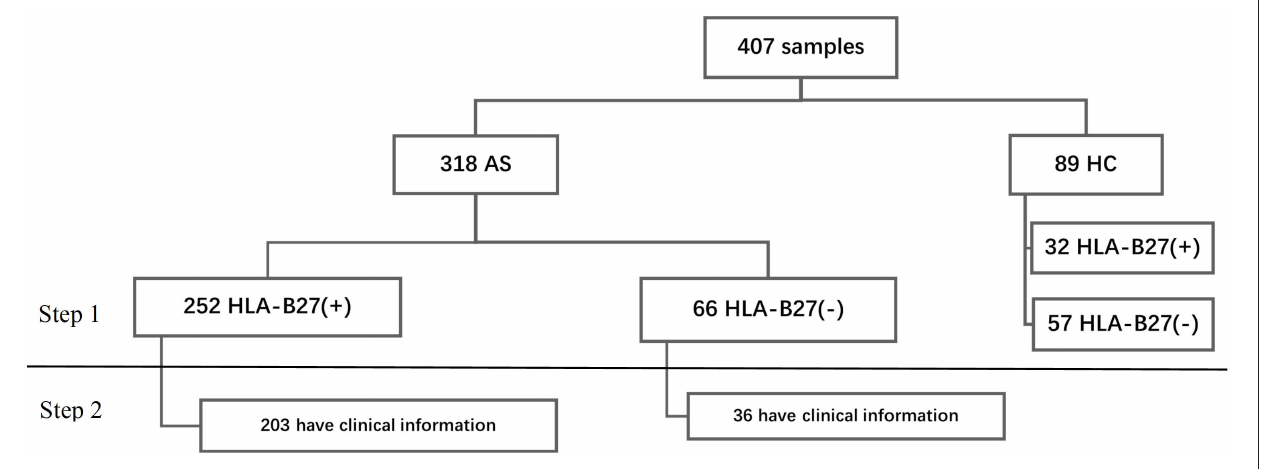
FIGURE 1 | Study flow chart.